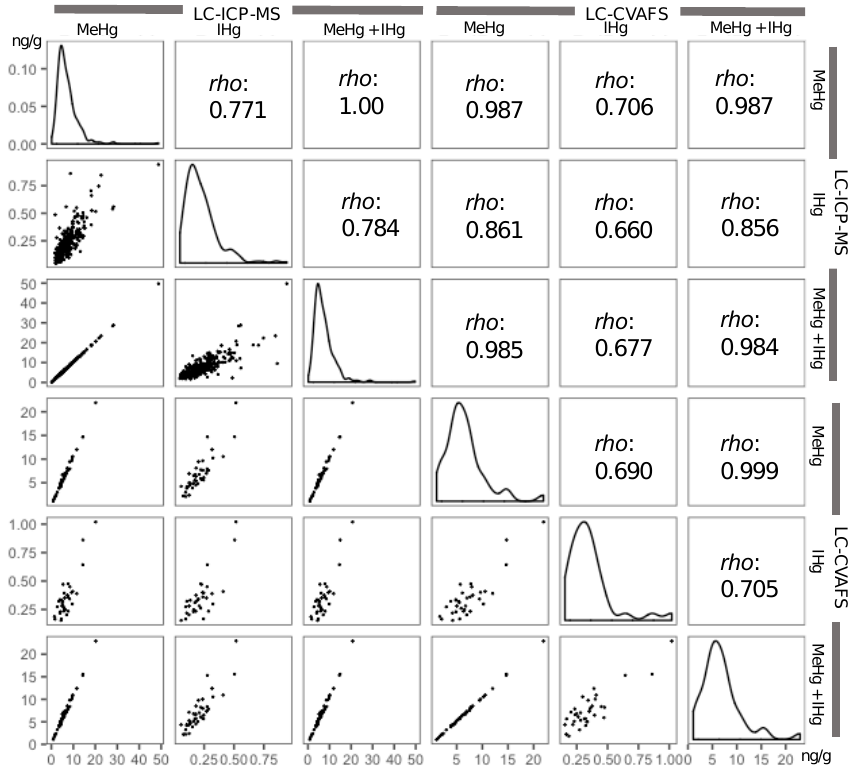
Figure 2. Correlation matrix plots between mercury concentrations (ng/g) in cord blood determined by LC-ICP-MS and LC-CVAFS. Correlation matrix plots show the distribution, ‘ rho ’ of Spearman’s correlation coefficients, and scatter plots. LC-ICP-MS: liquid chromatography-inductively coupled plasma mass spectrometry, LC-CVAFS: liquid chromatography-cold vapor atomic fluorescence spectrometry. The plots of more than method detection limit are shown.